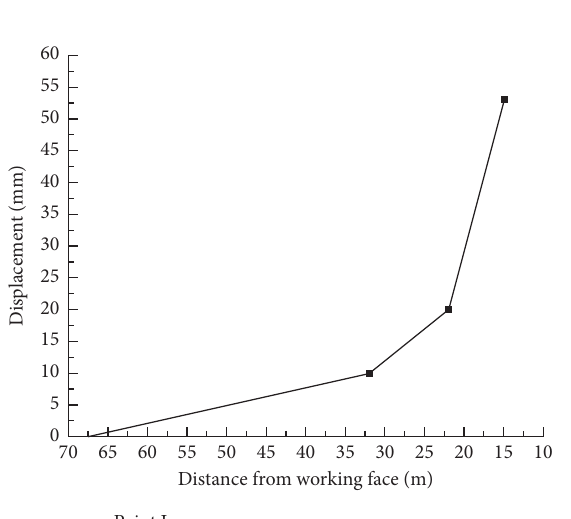
Figure 3: Displacements of roof and floor at Point II of main haulage